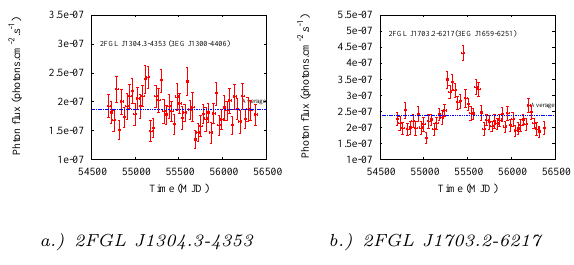
Figure 4: The gamma-ray lightcurves of the two Fermi-LAT sources, 2FGL J1304.3-4353 and 2FGL J1703.2-6217, which displayed variability over a period of 4.6 years. The vertical error bars indicate the 68% confidence level.